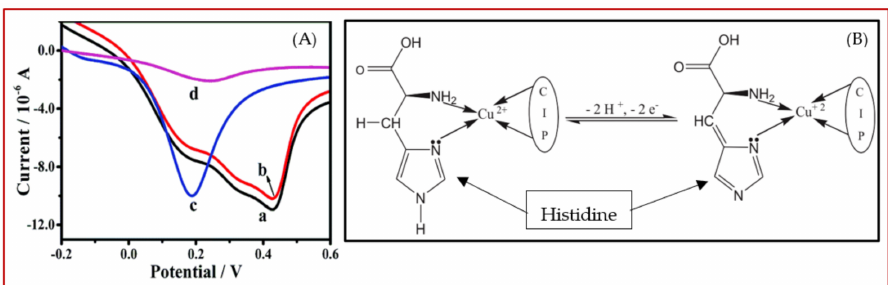
Figure 15. ( A ) Comparison of the linear sweep voltammograms for Cu-modified electrodes in the (a) absence and (c) presence of Cl − ions, after the addition of His (b) and (d). Reprinted with permission from ref. [400]. Copyright 2019 Royal Society of Chemistry. ( B ) The proposed structure of the complex formed between Cu (II) and histidine. Reprinted with permission from ref. [403]. Copyright 2011 Elsevier.